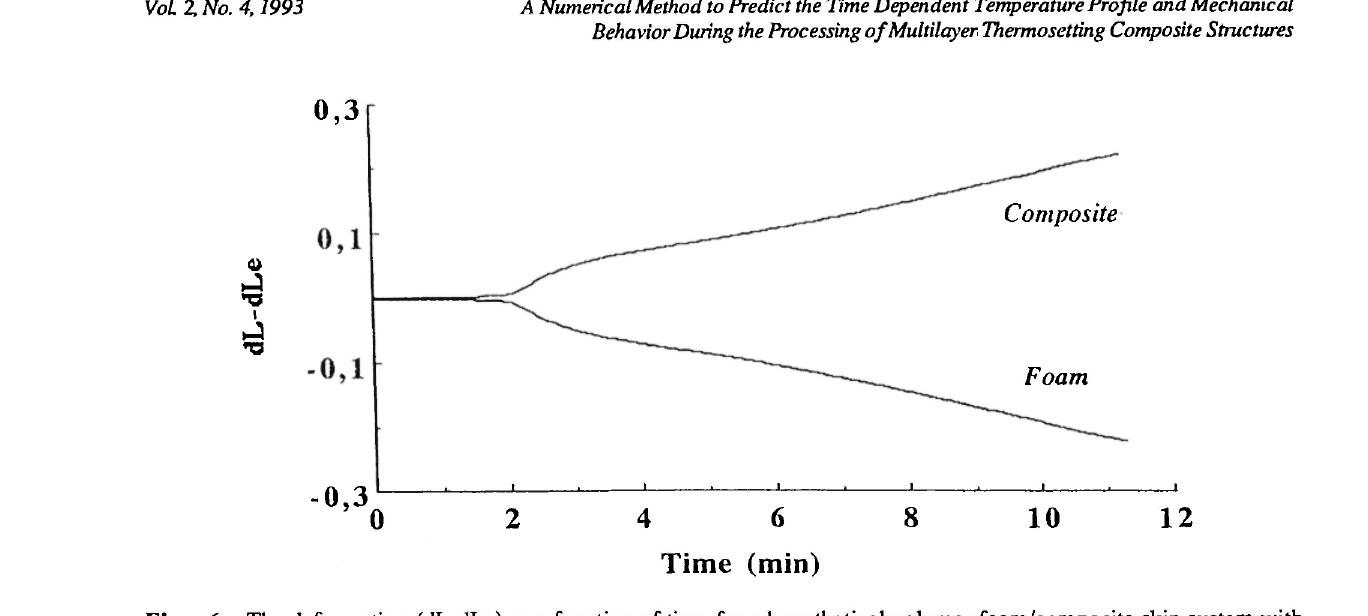
Fig. 6: The deformation (dL-dLe) as a function of time for a hypothetical polymer foam/composite skin system with constant strain boundary conditions (where dL is the total deformation and dLe is the initial deformation).